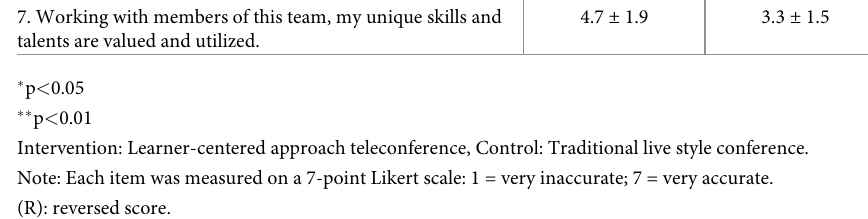
Group2 mean, SD p- (n = 15) (n = 19) value